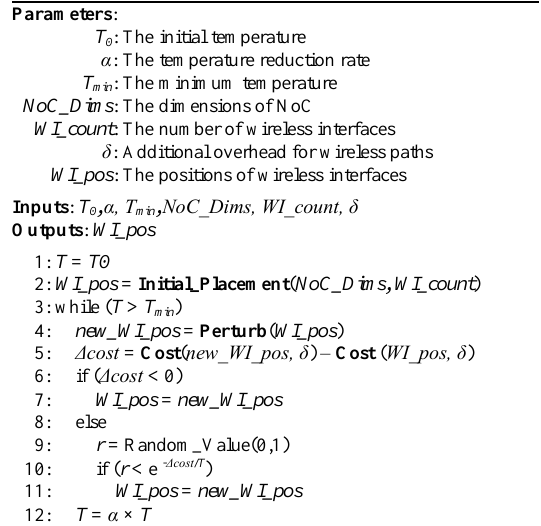
Algorithm 1. The proposed simulated annealing